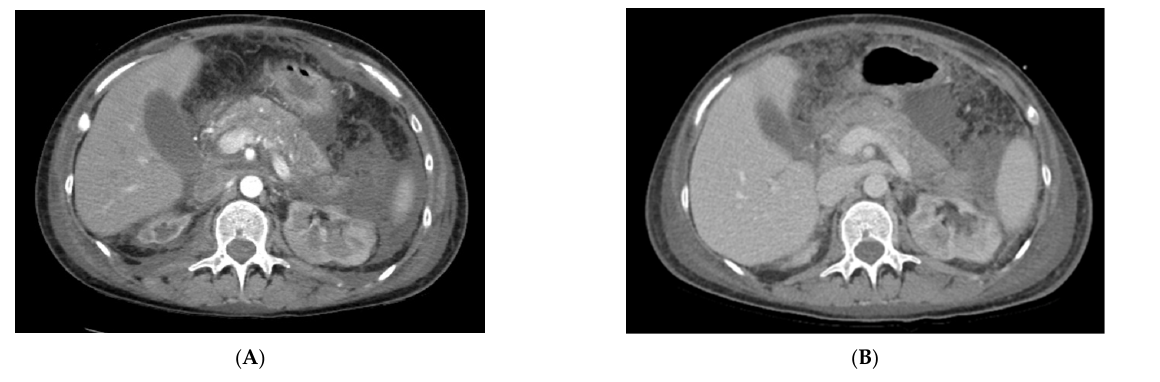
Figure 3. Abdominal CT scan in evolution. ( A ) Initial contrast-enhanced CT scan showing diffuse pancreatic edema and peripancreatic liquid collection. ( B ) Native CT scan revealing inhomogeneous pancreas characteristic of necrotizing pancreatitis, peripancreatic and retroperitoneal collection, and moderate ascites.